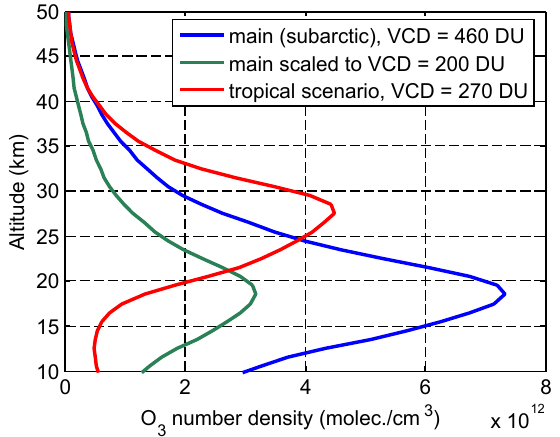
Fig. 2. Different ozone profiles applied for the simulation of spectra, air mass factor calculations and sensitivity